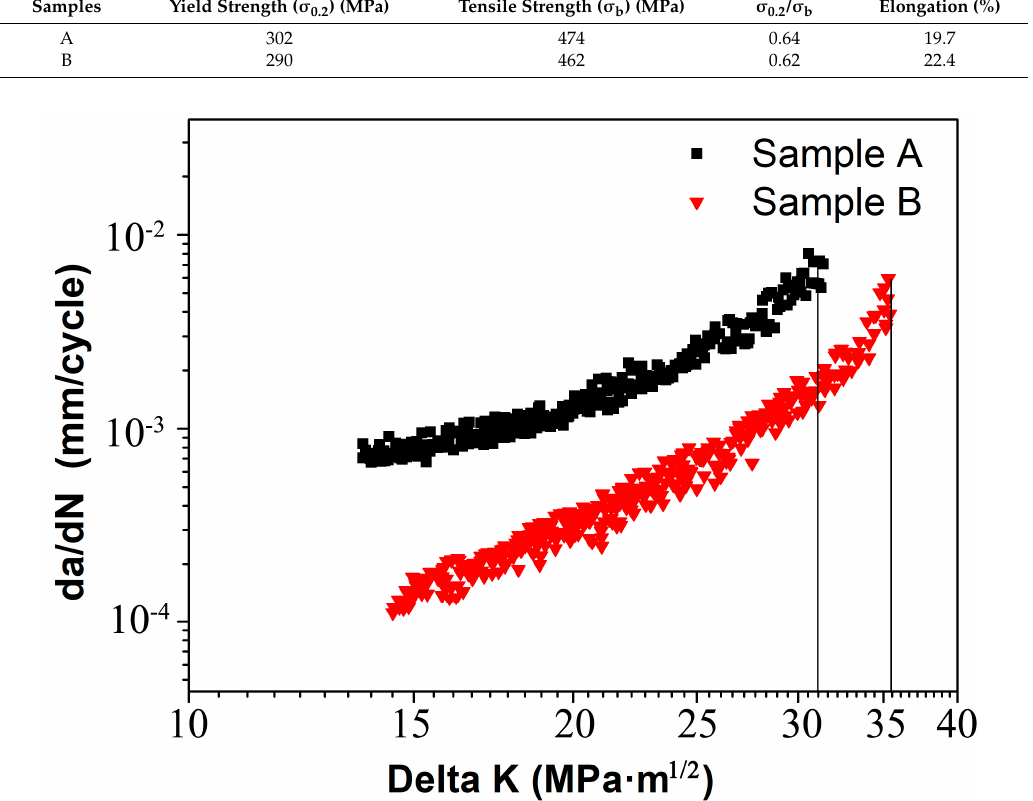
Figure 2. FCP rates, da/dN, as a function of Delta K for samples A and B.